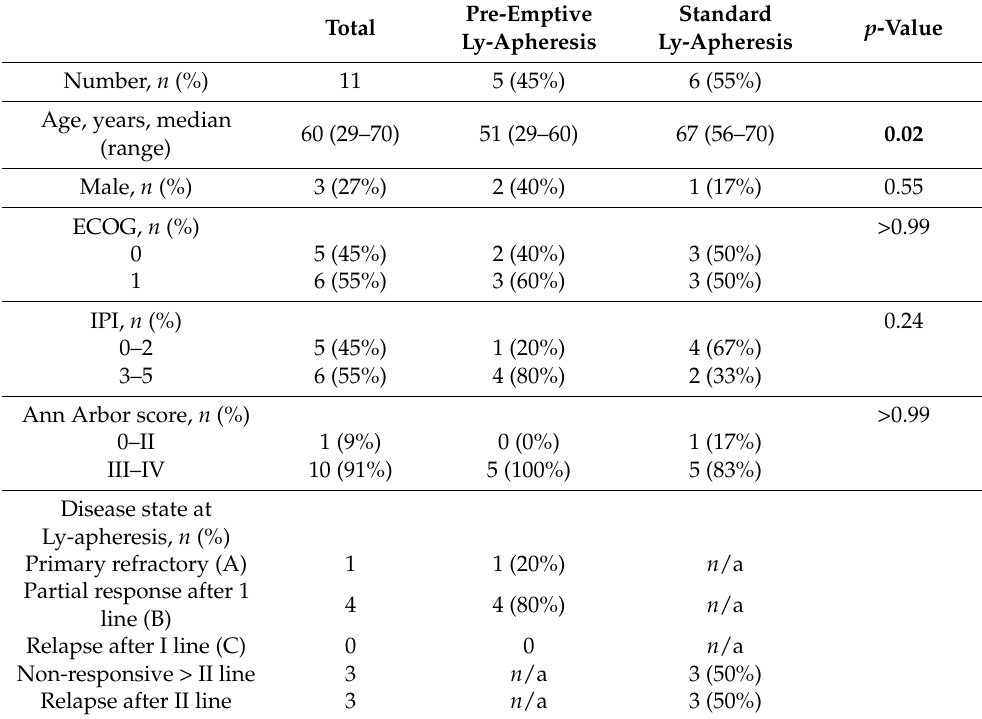
Figure 1. BIO-CAR-T BS study flow chart. ALL, acute lymphoblastic leukemia; CAR, chimeric anti- gen receptor; CR, complete remission; DLBCL, diffuse large B-cell lymphoma; PMBCL, primary mediastinal B-cell lymphoma; PR, partial remission. Table 2. Clinical characteristics of patients with DLBCL in the “pre-emptive” and standard Ly- apheresis groups. ASCT, autologous stem cell transplantation; CAR, chimeric antigen receptor; DLBCL, diffuse large B-cell lymphoma; ECOG, Eastern Cooperative Oncology Group; IPI, Interna- tional Prognostic Index; Ly, lymphocytes; n , number.